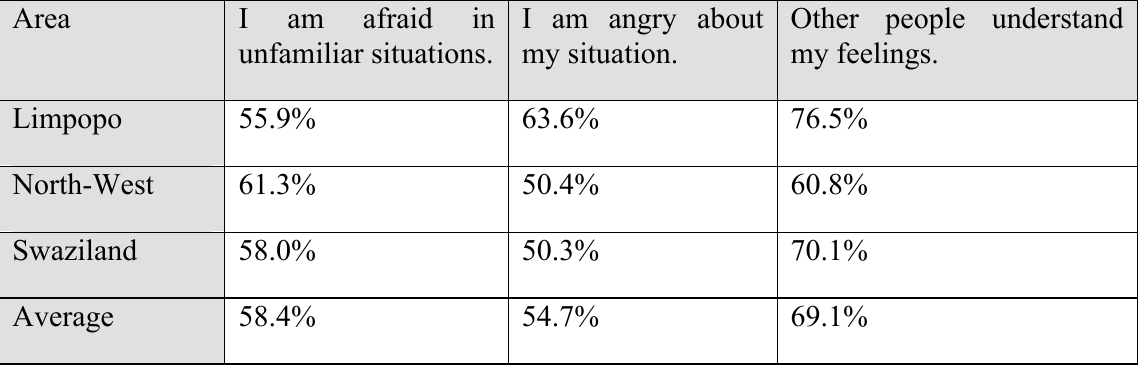
Table 8. Orphans’ responses on how they deal with their